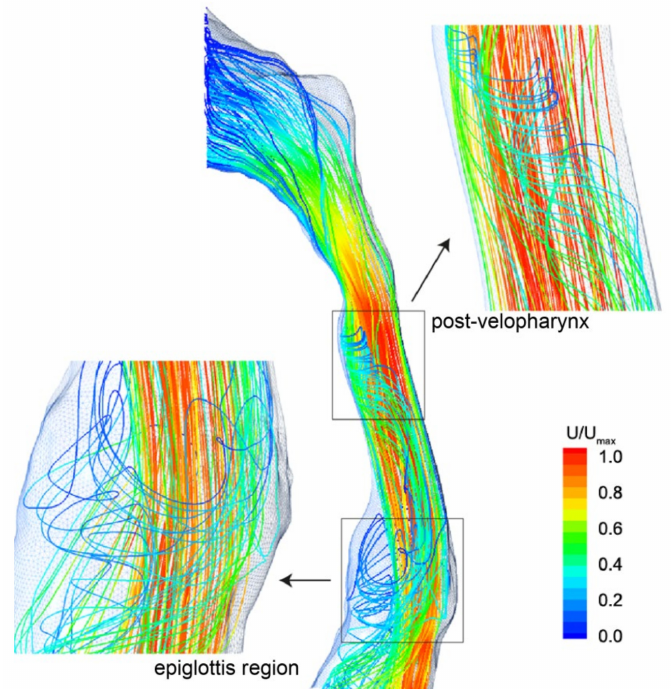
Figure 7. Streamlines coloured by velocity magnitude, highlighting the recirculating flow regions occurring downstream of the flow separation points.